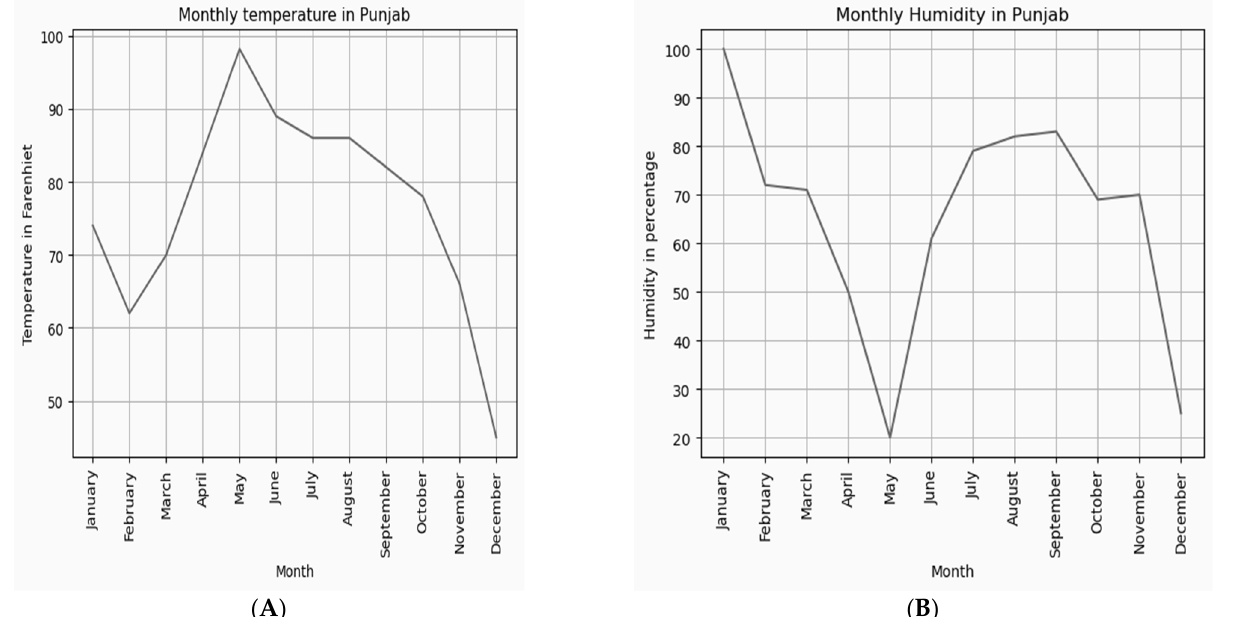
Figure 9. ( A ) Average temperature and ( B ) average humidity values throughout the year.